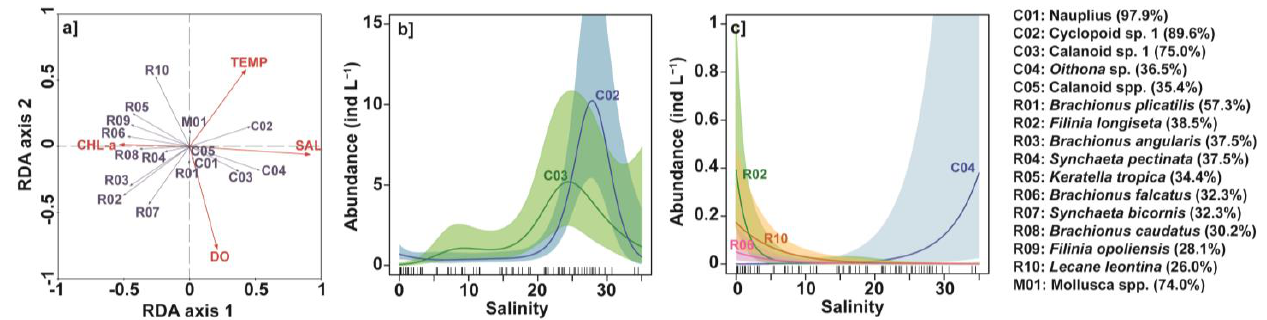
Figure 7. Redundancy analyses (RDA) and generalized additive models (GAMs) relating abundance of the most frequent zooplankton taxa to environmental variables. ( a ) RDA diagram of taxa abundances and environmental parameters. ( b , c ) GAMs of taxa abundances versus salinity (SAL). Only the three most significant ( p < 0.05) relationships are shown for copepods and rotifers. Note the change in scale between subplots ( b ) and ( c ). Taxa were coded according to the legend shown on the right (see also Table 1). Shaded areas indicate the 95% confidence intervals.